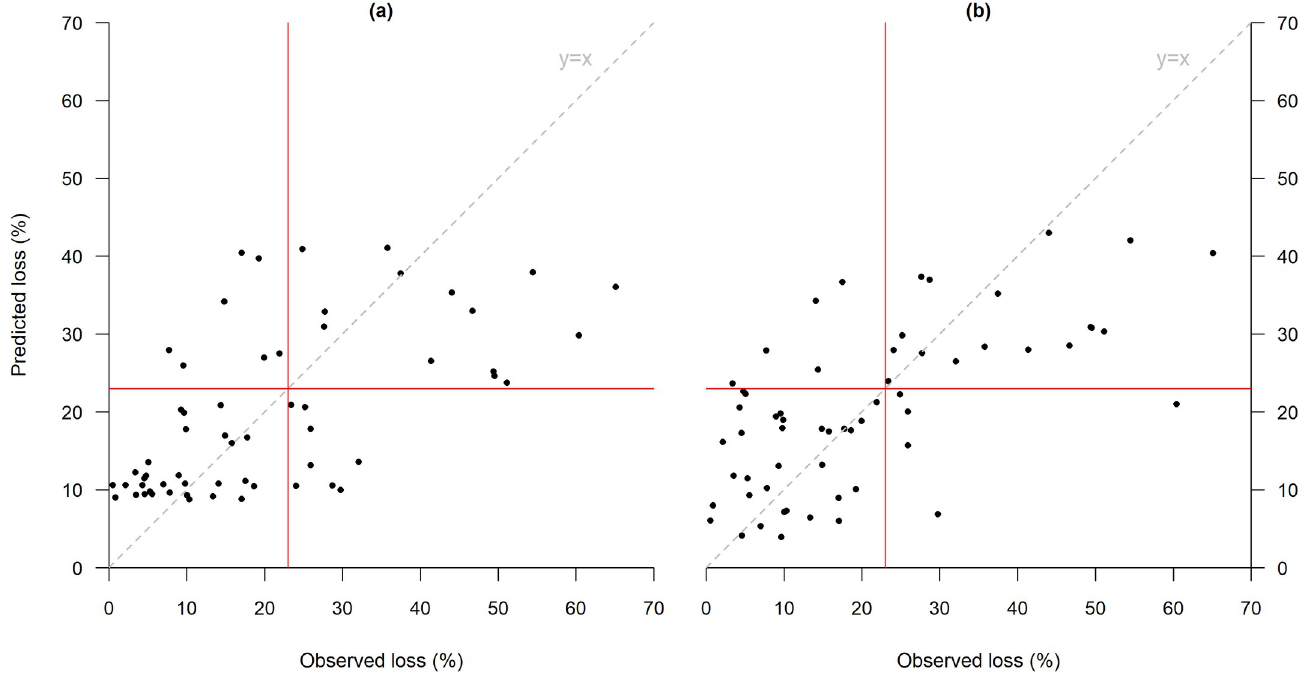
Fig 8. Predictive skill of models used in Fig 7(A) and 7(B) respectively. The red horizontal and vertical lines illustrates the mortality trigger at 23%.